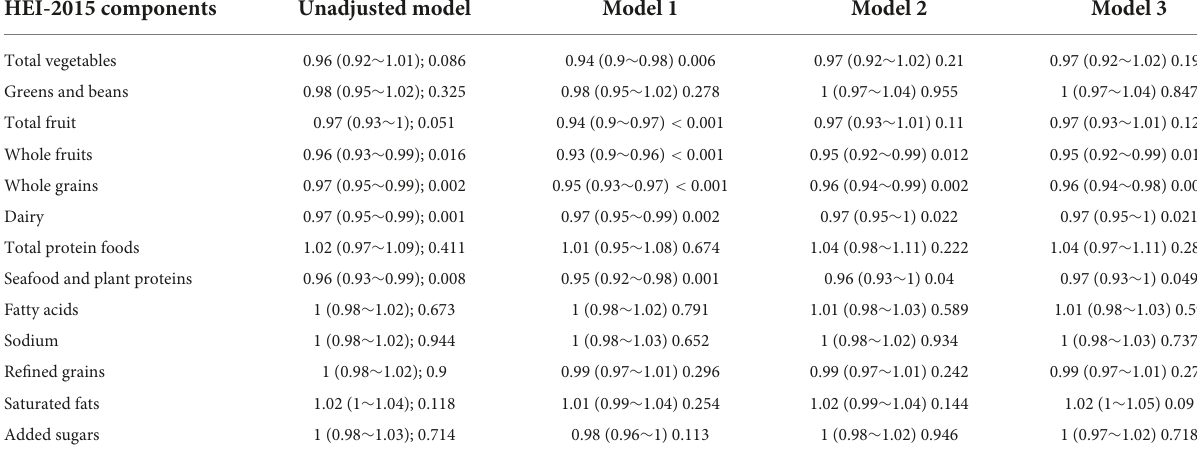
TABLE 4 Association of HEI-2015 components with